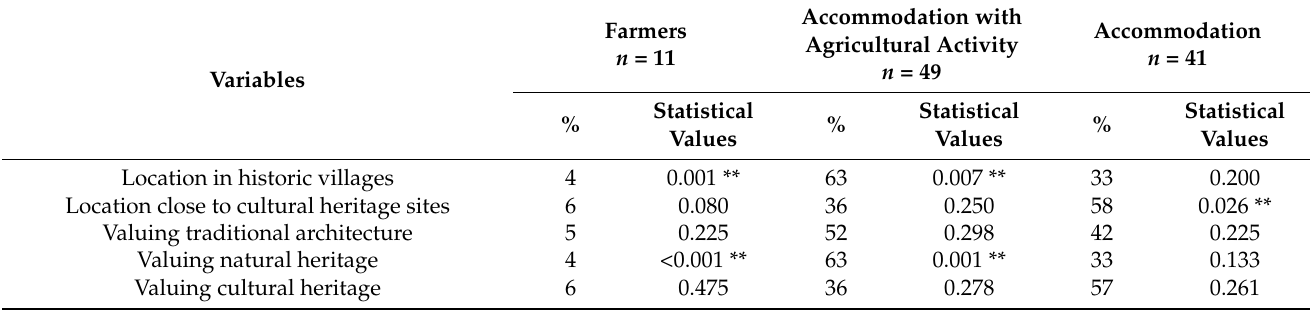
Table 5. A comparison of cultural and landscape variables between accommodation and other entrepreneurial agritourism models (Chi-square analysis of dummy variables).